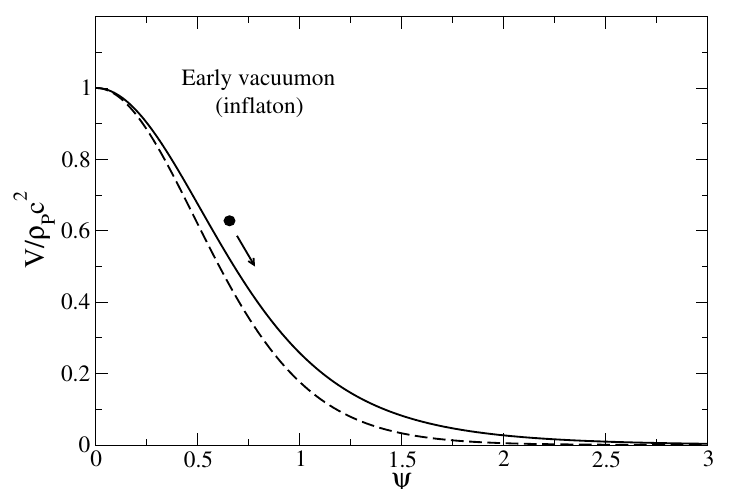
Figure 1. Potential of the scalar field in the early universe for α = 1/3 (solid line) and α = 1 (dashed line). The early vacuumon plays the role of the inflaton. The field tends to run down the potential. Recalling that x = ( a / a 1 ) 3 ( α + 1 ) /2 and using Equation (113), the relation between the scalar field and the scale factor